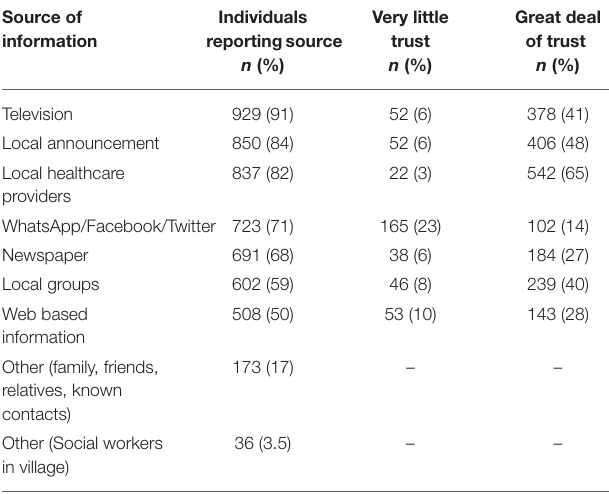
TABLE 3B | Participants reporting sources of information for Covid and level of trust.